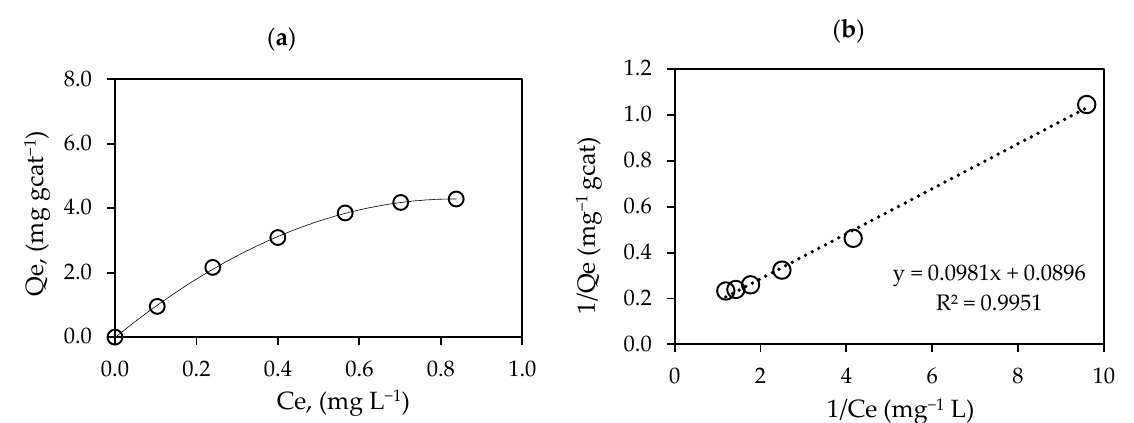
Figure 9. ( a ) Hydrogen peroxide adsorption isotherm on a Pd-TiO 2 photocatalyst and ( b ) linearized langmuir equilibrium isotherm for hydrogen peroxide on Pd-TiO 2 . Table 3. Adsorption constants for hydrogen peroxide and ethanol.